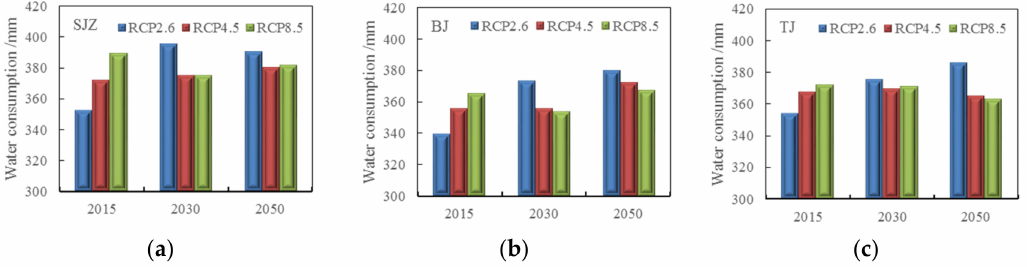
Figure 7. The water consumption of winter wheat in the different RCP scenarios. ( a – c ) are water consumption for Shijiazhuang, Beijing, and Tianjin,